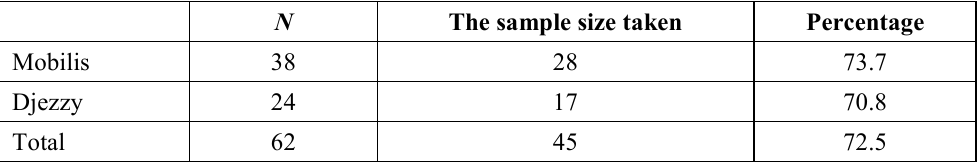
Table 1 . Corporate Data and how to choose the sample N The sample size taken Percentage Mobilis